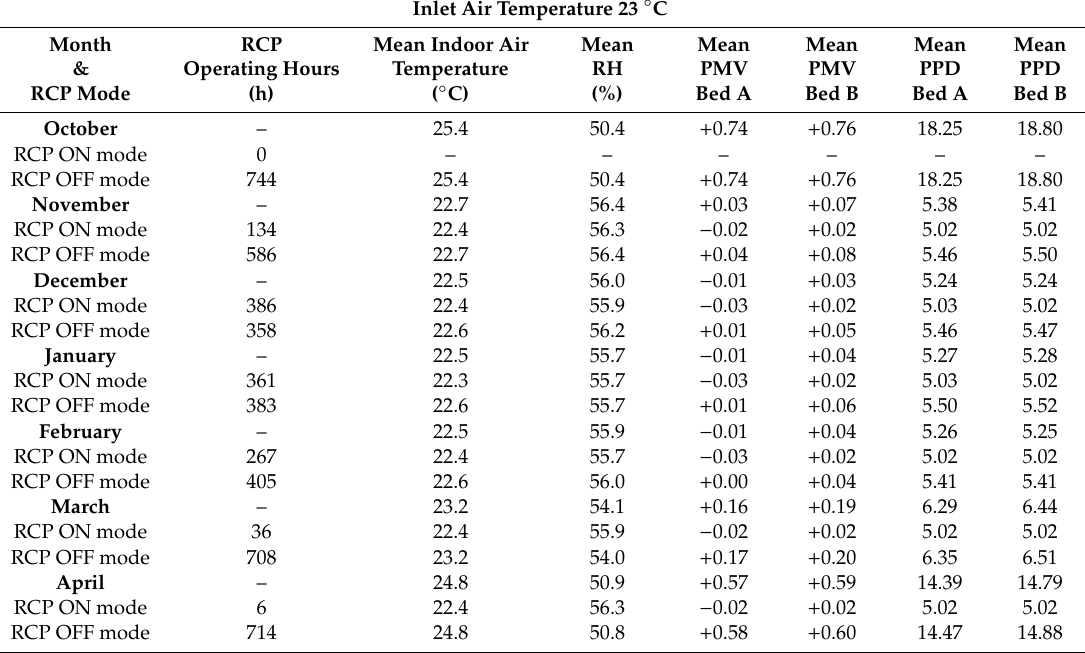
Table 8. Monthly RCP operating hours, mean indoor air temperature, RH, PMV and PPD with inlet air temperature of 23 ◦ C.